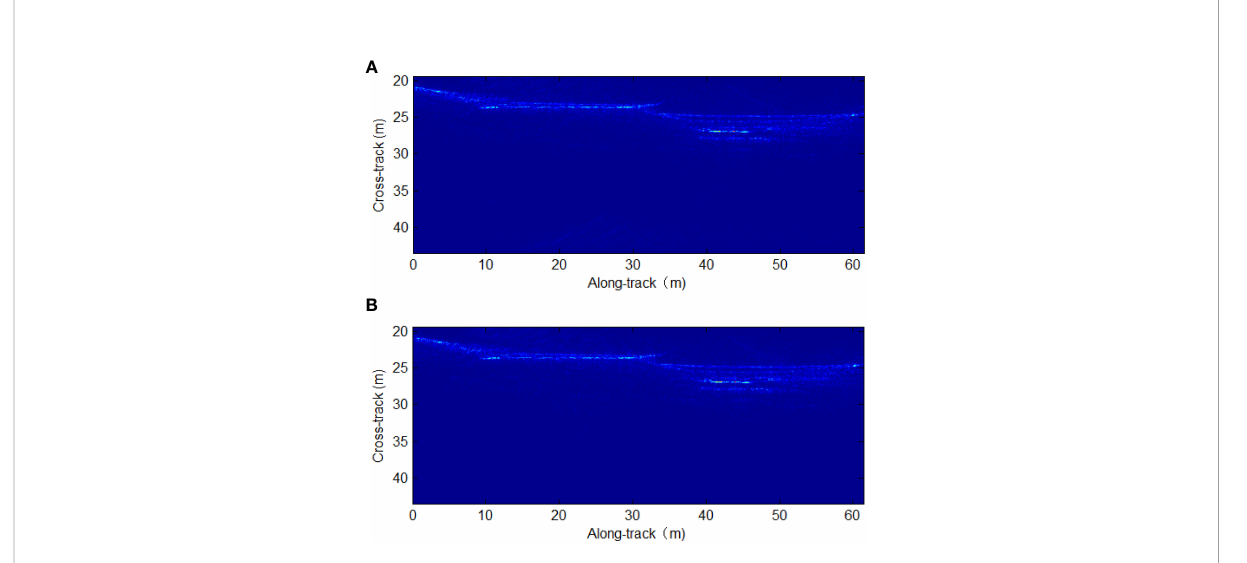
FIGURE 8 Processing results for real data. (A) Proposed method. (B) Back-projection (BP) algorithm.